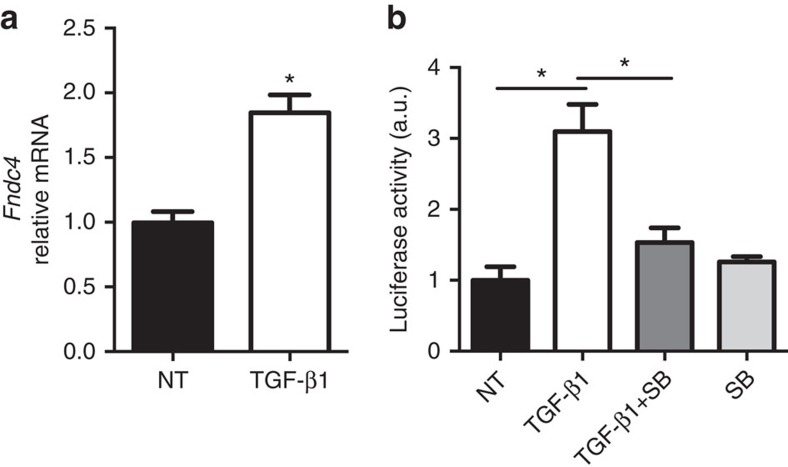
TGFβ induces FNDC4 expression.(a) FNDC4 expression in Caco-2 cells after 20 h treatment with 20 ng ml−1 TGFβ1. N=4. Mean±s.e.m., *P<0.05, Student's T-test. (b) Luciferase assay. McA-RH7777 cells were transfected with an Fndc4 promoter reporter construct and treated with 20 ng ml−1 TGFβ1 and/or TGFβ1R antagonist SB-431542 (SB) (20 μM) for 20 h. N=4–5. Mean±s.e.m., *P<0.05 (one-way analysis of variance with Tukey's post hoc tests).